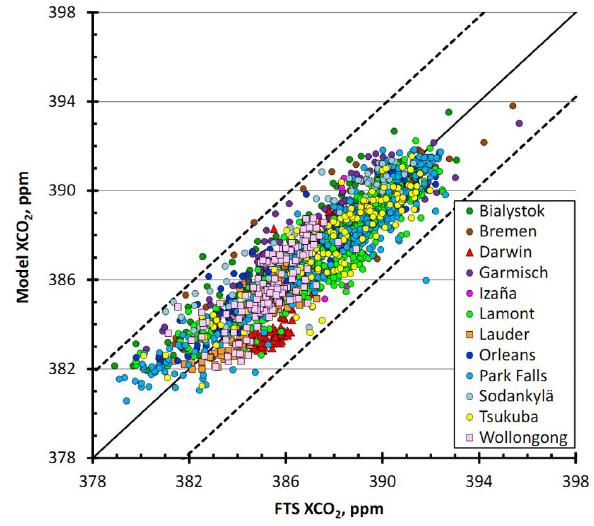
Fig. 13. As for Fig. 11, but for XCO 2 . 1025